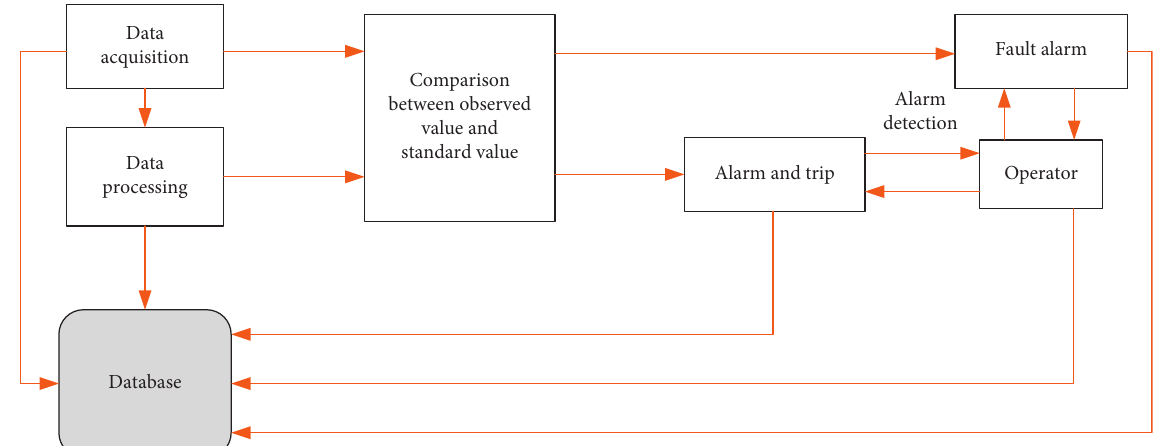
Figure 6: Flowchart of model data monitoring and processing of electrical automation monitoring